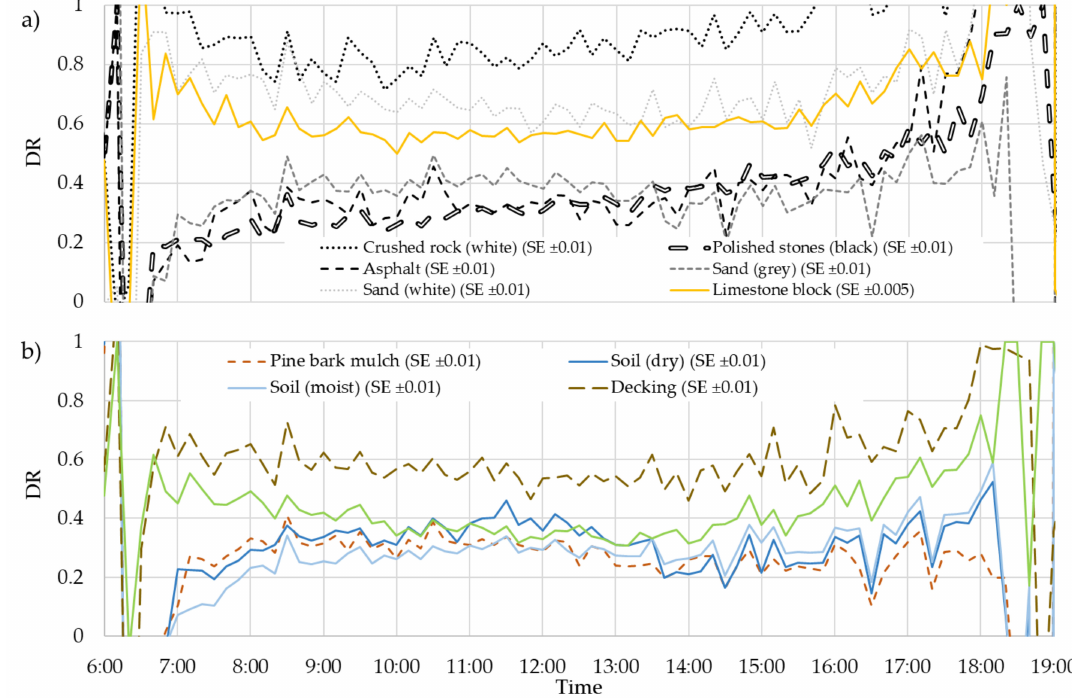
Figure 10. Daytime ratio (T iB,LE –T amb ) over (T iB,WPP –T amb ) for LEs, summer 2018. Comparison of: ( a ) rocks, sand, and high thermal inertia LEs; and ( b ) softscape or natural LEs. Data from 09:00 to 15:40 were averaged. Standard errors (SE) were calculated assuming random errors and a normal distribution